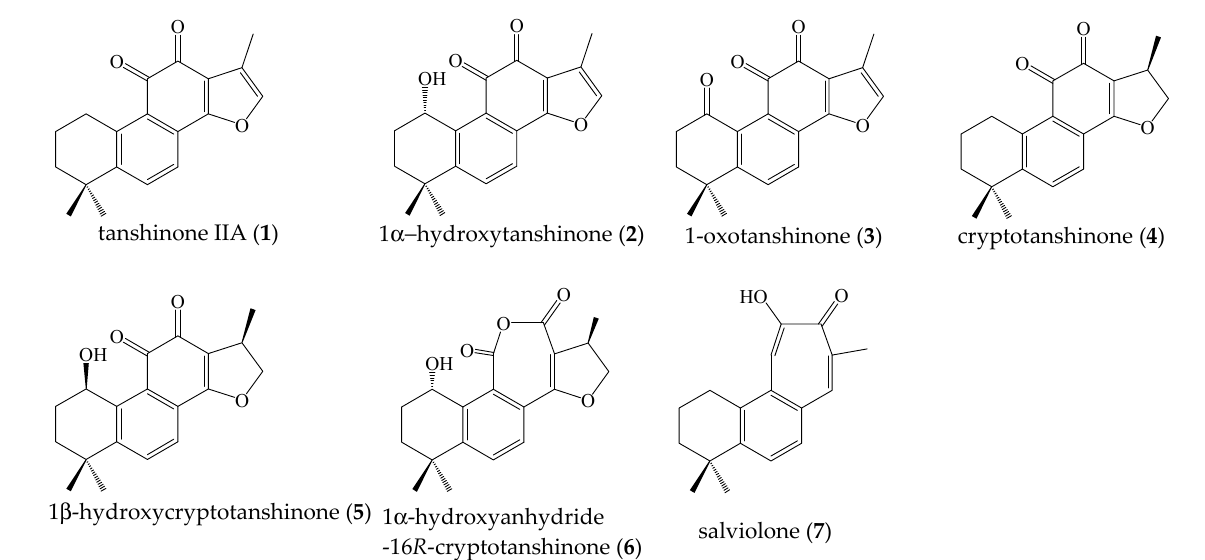
Figure 1. Compounds isolated from S. miltiorrhiza roots.